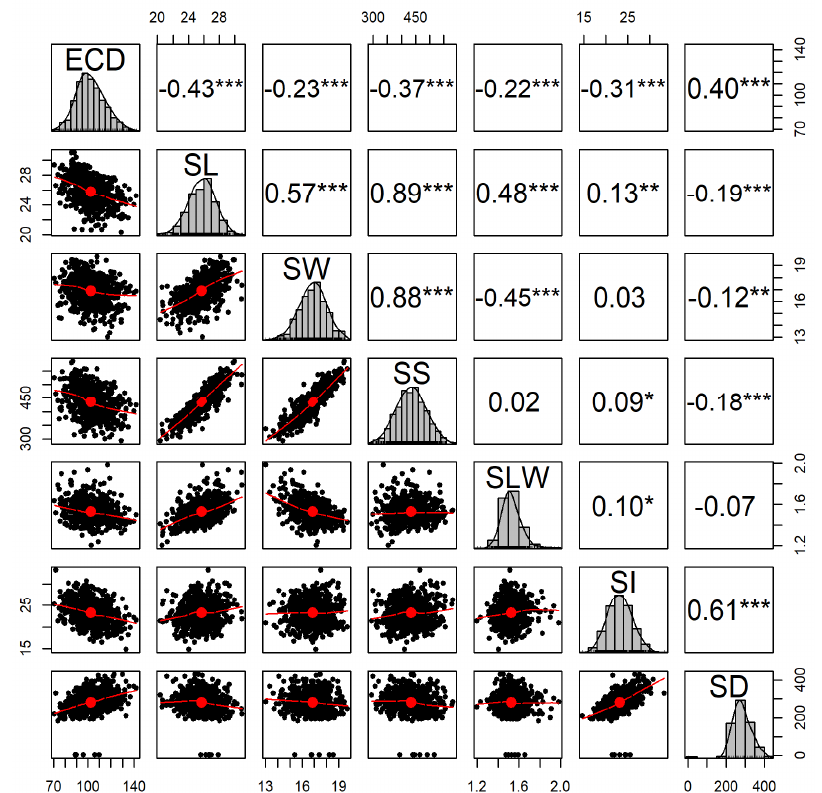
Figure 3. Correlations between the leaf morpho-anatomical traits: ECD, epidermal cell density (cells mm − 2 ); SI, stomatal index (%); SD, stomatal density (unit mm − 2 ); SS, stomatal size (stomatal length × stomatal width); SL, stomatal length (major axis; μ m); SW, stomatal width (minor axis; μ m); SLW, stomatal length/width (indicative of shape) of 43 Coffea canephora genotypes. (*, **, and *** correspond to significance of p < 0.05, p < 0.01, and p < 0.001, respectively). Table 5. Correlations between the yield and leaf morpho-anatomical traits of 43 Coffea canephora genotypes. Morpho-Anatomical Traits Yield